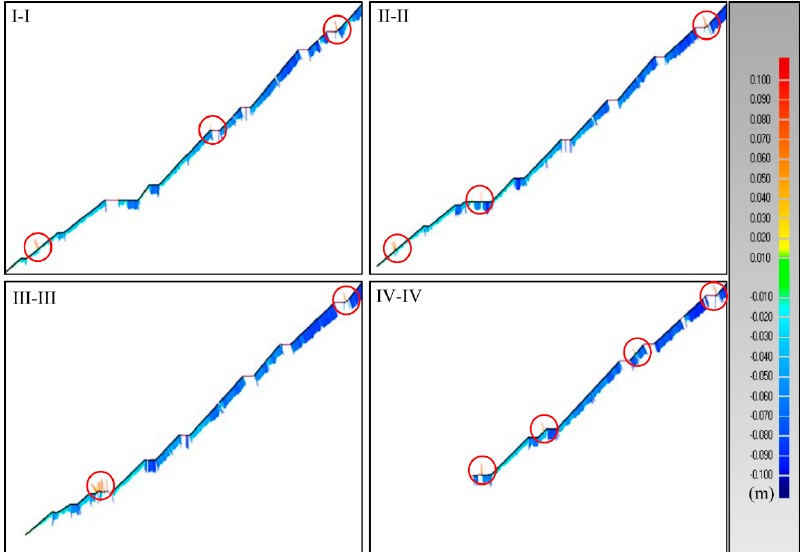
Figure 10. The deformation distribution along longitudinal sections.